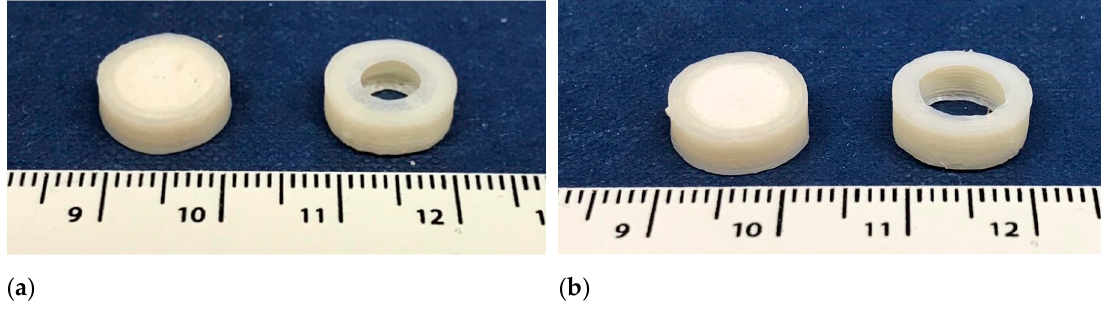
Figure 8. ( a ) P6-100 before (left) and after (right) the dissolution test; ( b ) P8-100 before (left) and after (right) the dissolution test. Ruler in cm.